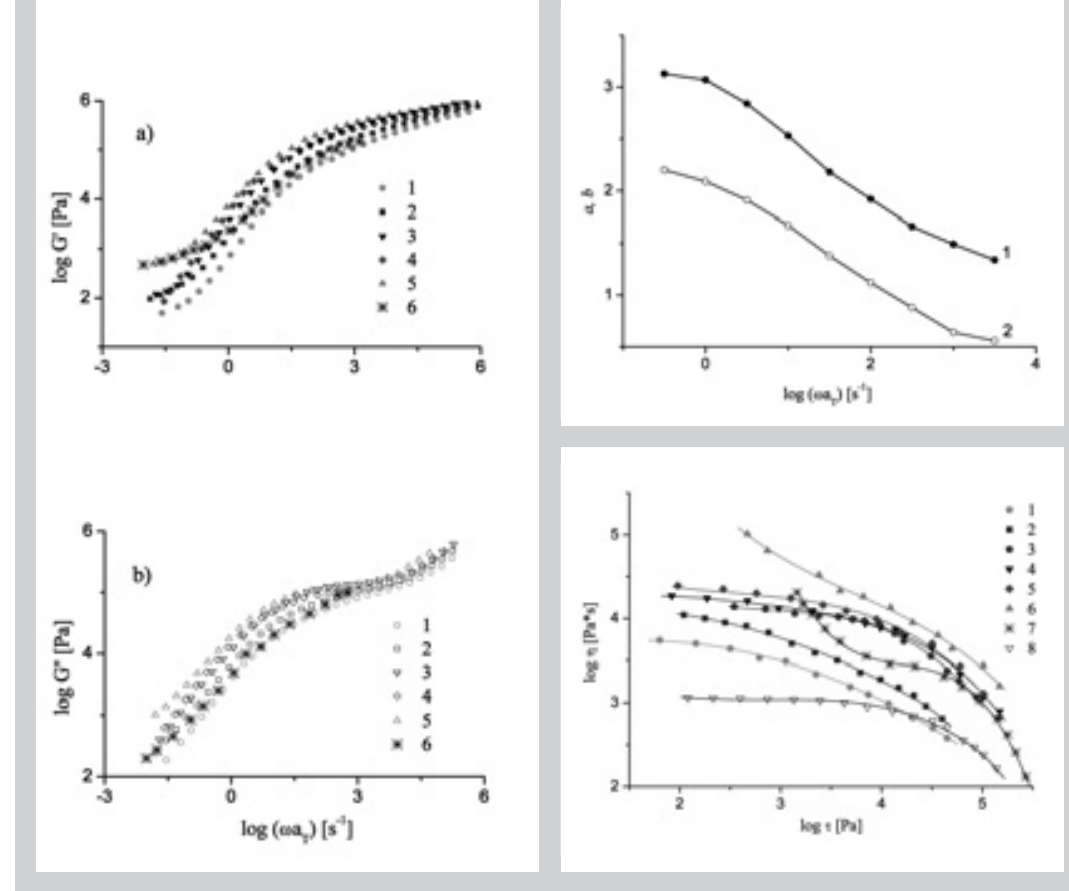
Figure 3 (left): ) (a) Master curves G’ ( w a T and G’’ ( w a ) (b) for ABS-1 (1), T ABS-2 (2), ABS-4 (3), ABS-5 (4), ABS-6 (5) and the model ABS (the data were taken from [10]) (6) (T = 250° C). Figure 4 (right above): Frequency dependence of the exponents a(1) and b(2) in Eq. 1 (T = 250° C). Figure 5 (right below): Shear viscosity versus shear stress for ABS-1 (1), ABS-2 (2), ABS-3 (3), ABS-4 (4), ABS-5 (5), ABS-6 (6), the model ABS (the data were taken from [17]) (7) and the neat SAN (8) (T = 250°